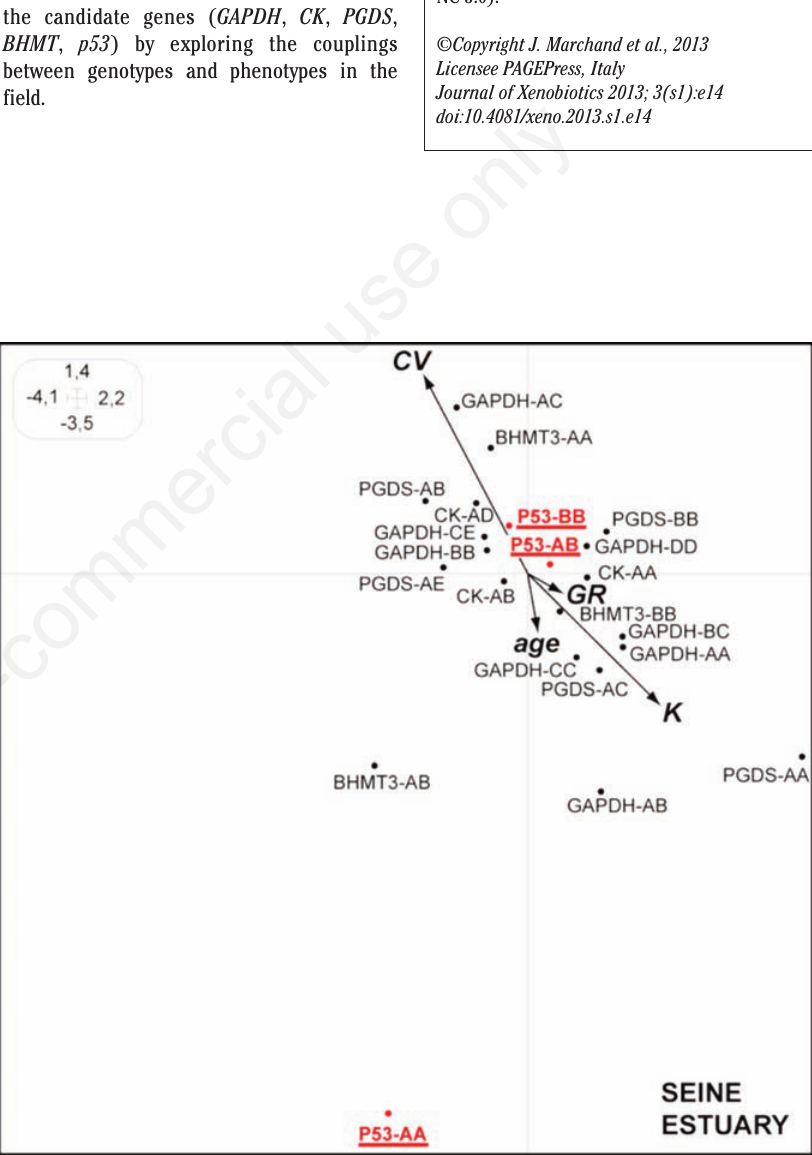
Figure 1. Synthetic Hill and Smith analysis for European flounders from the Seine estu- ary linking quantitative variables (CV, coefficient of variation of DNA content of blood cells; GR, growth rate; K, condition factor; F, relative fecundity) and qualitative data (genotypes) The main 2 first axes explain 54% of the total variance (ovoid box shows the limit of the